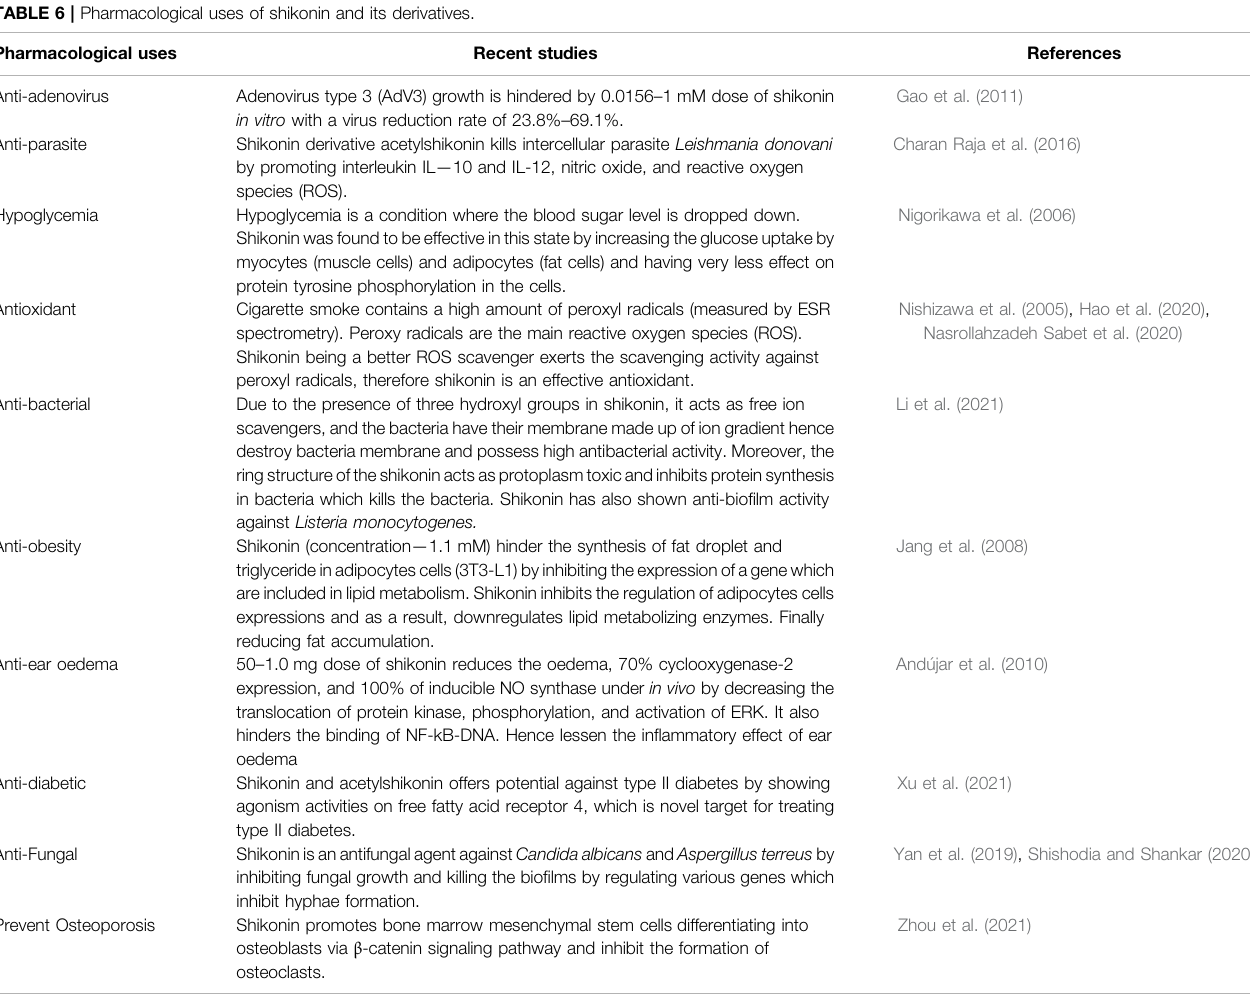
TABLE 6 | Pharmacological uses of shikonin and its